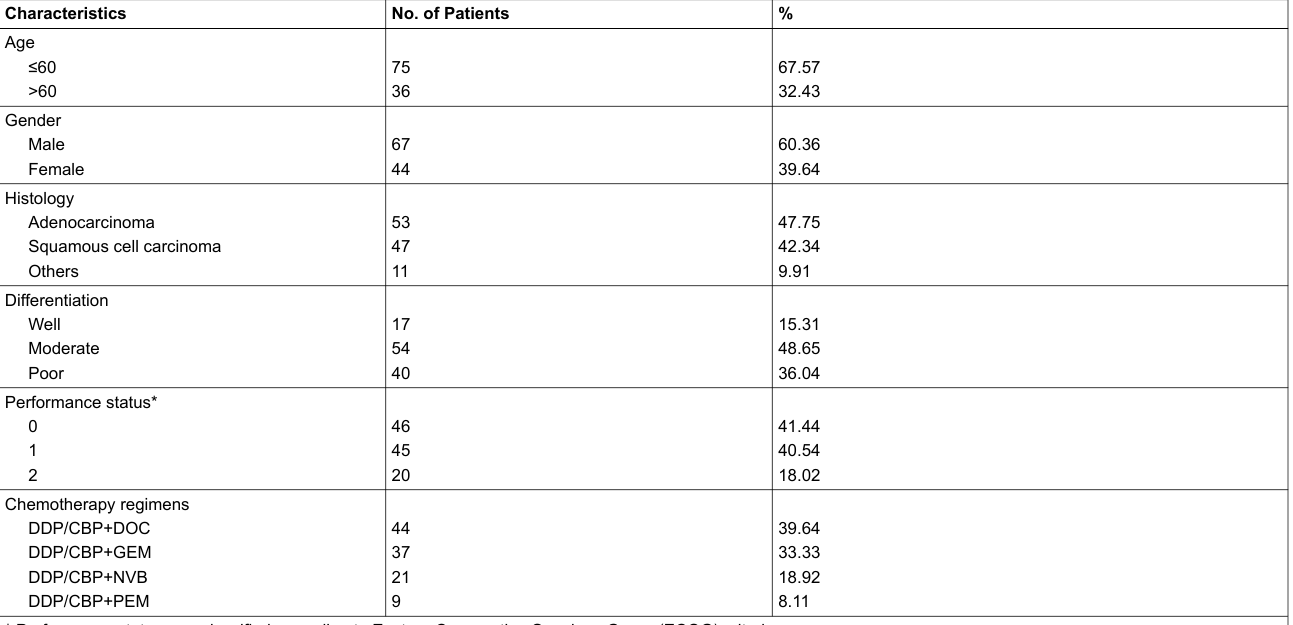
Table 1: Patient clinicopathological characteristics and chemotherapy regimens (n = 111).